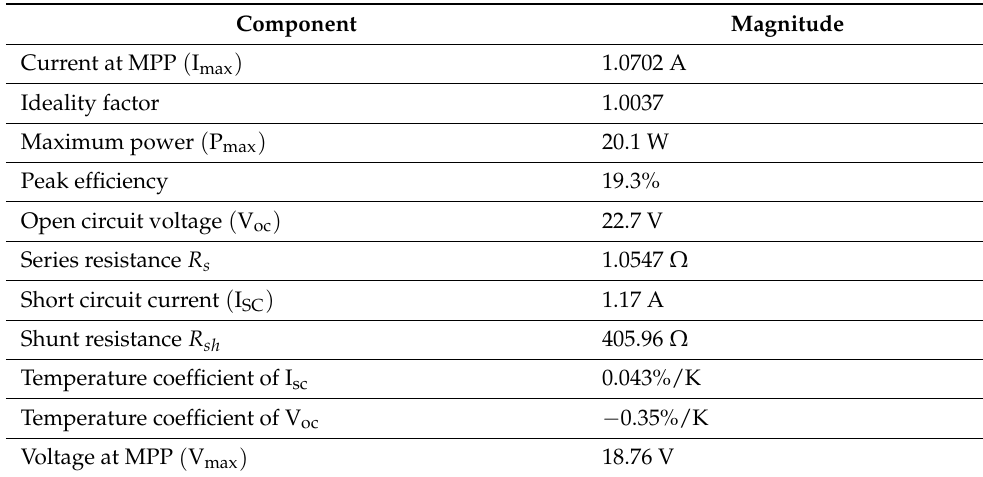
Figure 14. Hardware setup figure. Table 4. The electrical characteristics of hardware modules.